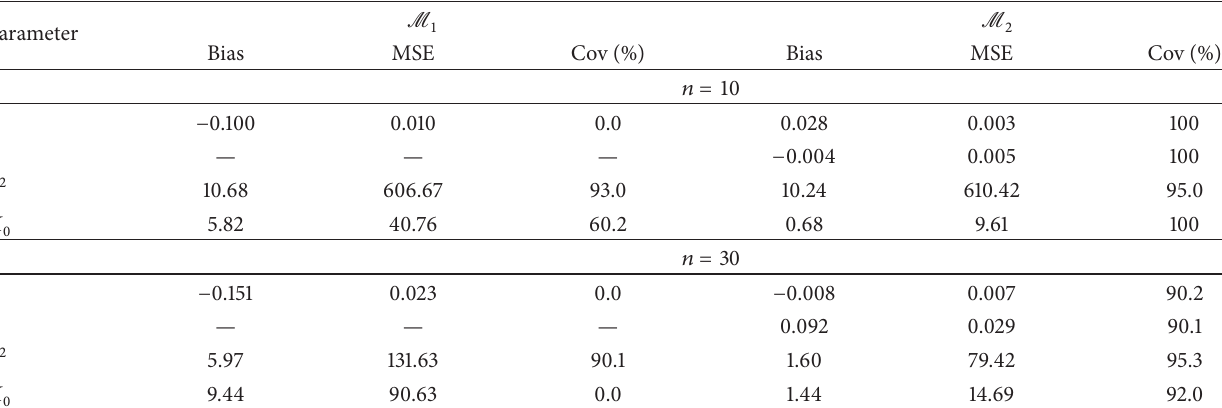
Table 2: Estimated Bias, MSE, and coverage, with 𝑋 0 unknown.